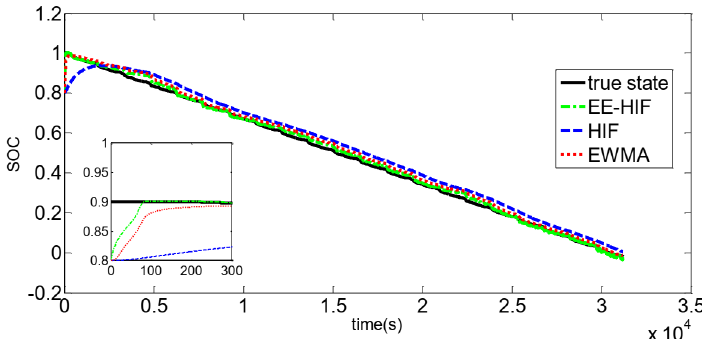
Figure 11. The estimated state curve of the three